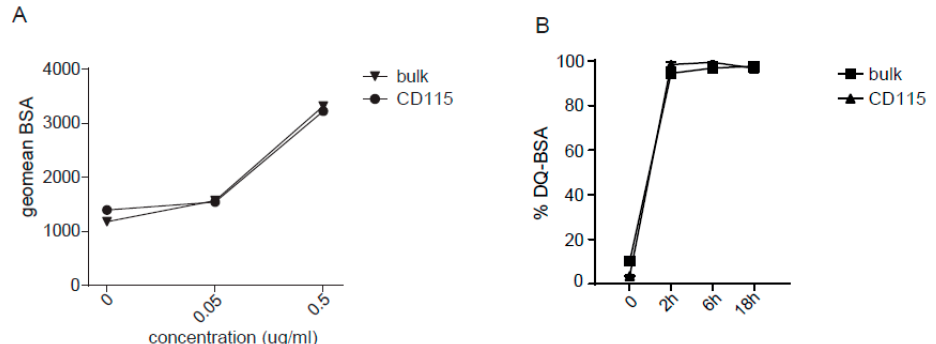
Figure 2. CD115-DCs can take up and process antigen. ( A ) Uptake of increasing doses of BSA-FITC by DCs from the standard or CD115 culture. The geometric mean of FITC + signal taken up at 37 °C is shown minus the FITC + signal detected at 4 °C. ( B ) The processing of BSA-DQ is shown as a percentage of DQ-BSA gated within the DCs from the standard or CD115 culture at indicated time points. The DQ signal seen at 4 °C is subtracted from the DQ + cells at 37 °C. Data represent two independent experiments. The experiments were performed at least three times.